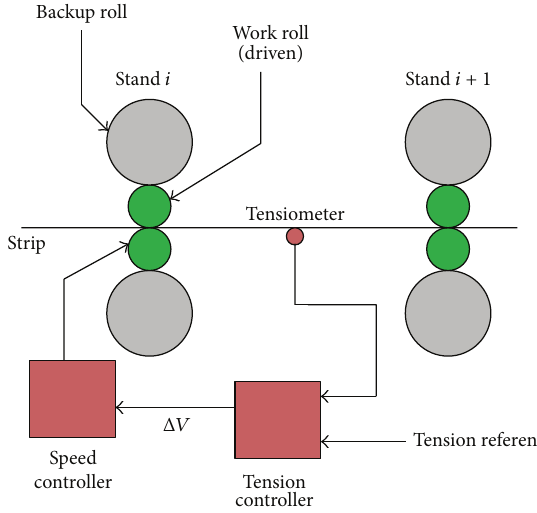
Figure 1: Schematic of conventional tension control for TCM.